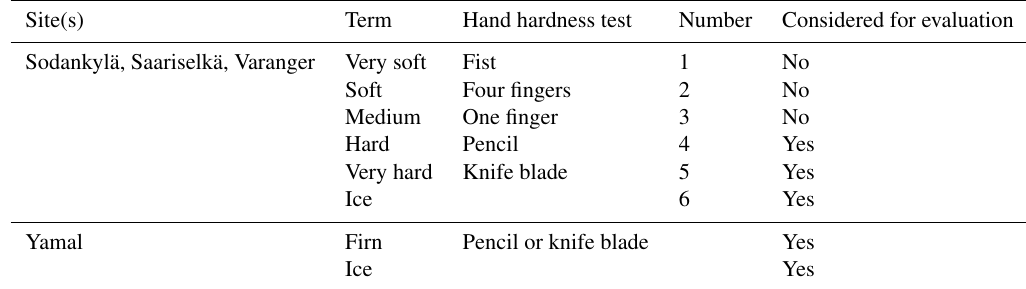
Table 1. Overview of terms for snow hardness documentation for available snowpit observations. Site(s) Term Hand hardness test Number Considered for evaluation Sodankylä, Saariselkä, Varanger Very soft Fist